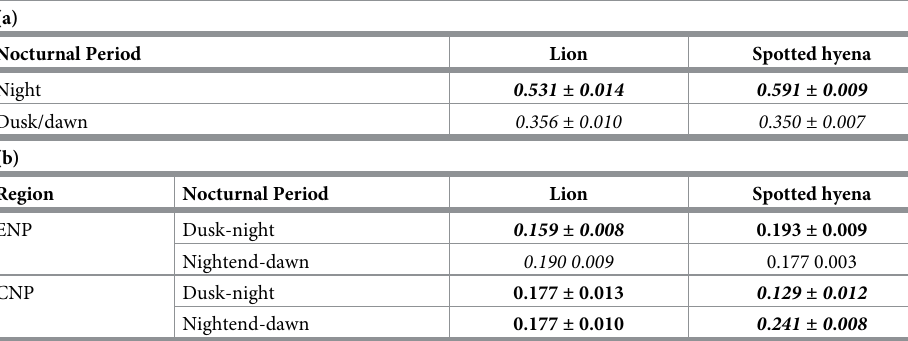
Table 7. Proportion of species activity during the nocturnal period.